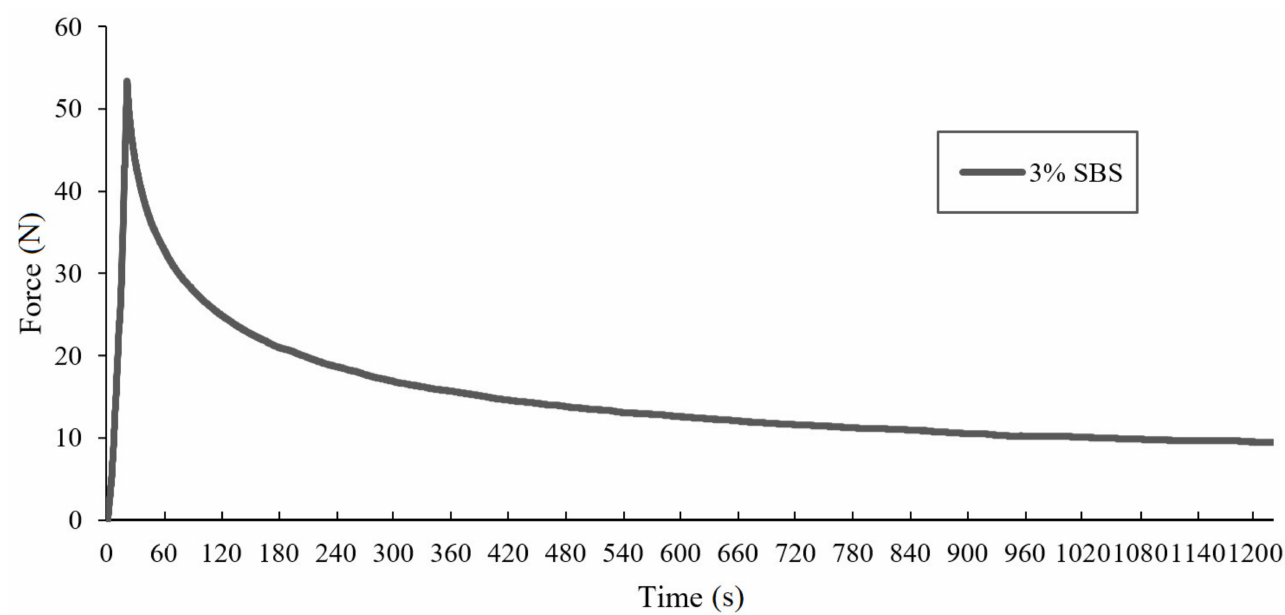
Figure 6. Results obtained from the force-ductility-relaxation test at − 16 ◦ C conducted for one sample of the asphalt binder modified with 3% of SBS copolymer.